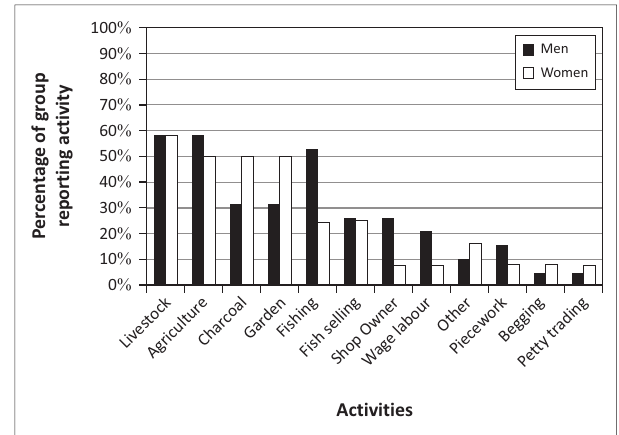
FIGURE 17: Livelihoods activities by gender in Group